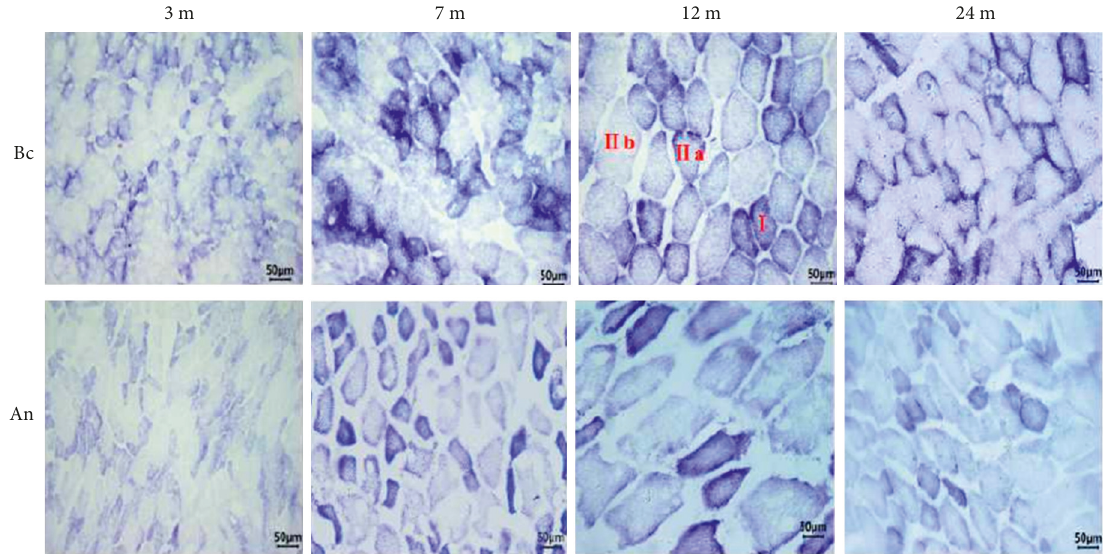
Figure 2: The longissimus dorsi muscle SDHase staining of Xinjiang brown cattle and Angus cattle ( ×